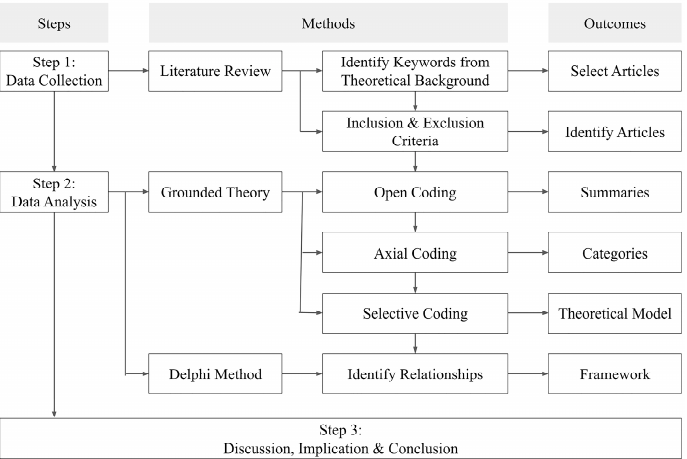
Figure 1. The Analytical Framework.